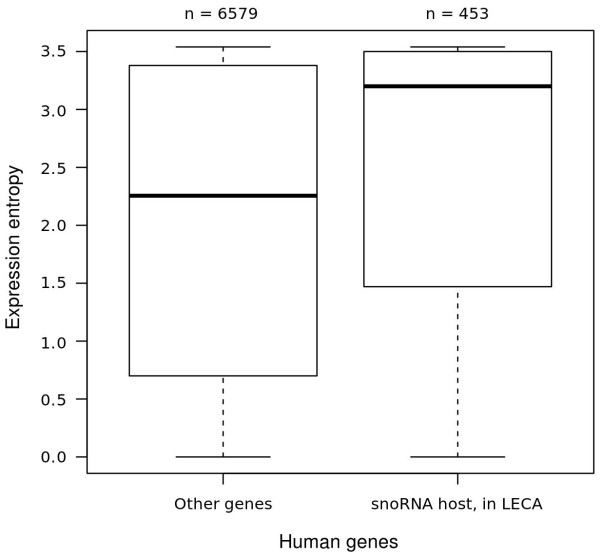
Expression entropy (breadth of expression across tissues) based on data from the Norvatis transcriptome atlas [45]shows that deeply conserved, snoRNA carrying host genes are generally more broadly expressed than non-carrying genes. On the backdrop of a requirement for broad snoRNA expression, this may suggest a selective advantage for this association. A total of 7022 genes were considered, based on usable expression data and reliable correlation to EnsEMBL genes ids in release 58.